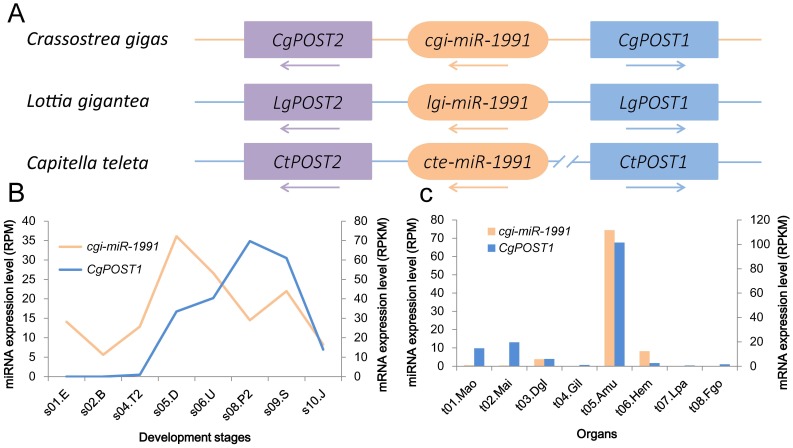
Genomics and expression of mir-1991 and the Post gene cluster.
A. Location of the mir-1991 in the Post clusters in Crassostrea gigas, Lottia gigantea and Capitella teleta. Arrow shows the strand orientation of the gene. B. The expression pattern of oyster miRNA cgi-miR-1991 and oyster gene CgPOST1 in different development stages. The samples are abbreviated as follows: s01.E, egg; s02.B, blastula; s04.T2, trochophore; s05.D, D-shape larva; s06.U, umbo larva; s08.P2, pediveliger larva; s09.S, spat; s10.J, juvenile. c. The expression pattern of oyster miRNA cgi-miR-1991 and oyster gene CgPOST1 in different organs. The samples are abbreviated as follows: t01.Mao, outer edge of mantle along the margin of the shell; t02.Mai, inner pallial part covering the inner surface of the shell; t03.Dgl, digestive gland; t04.Gil, Gill; t05.Amu, adductor muscle; t06.Hem, hemolymph; t07.Lpa, labial palps; t08.Fgo, female gonad.